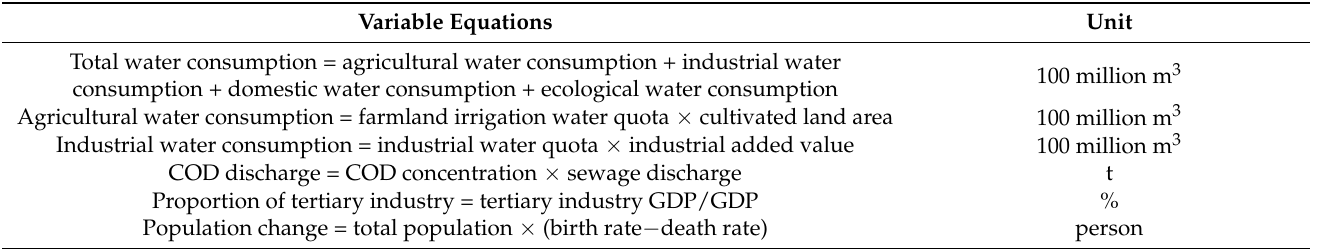
Table 3. Variable equations in the governing